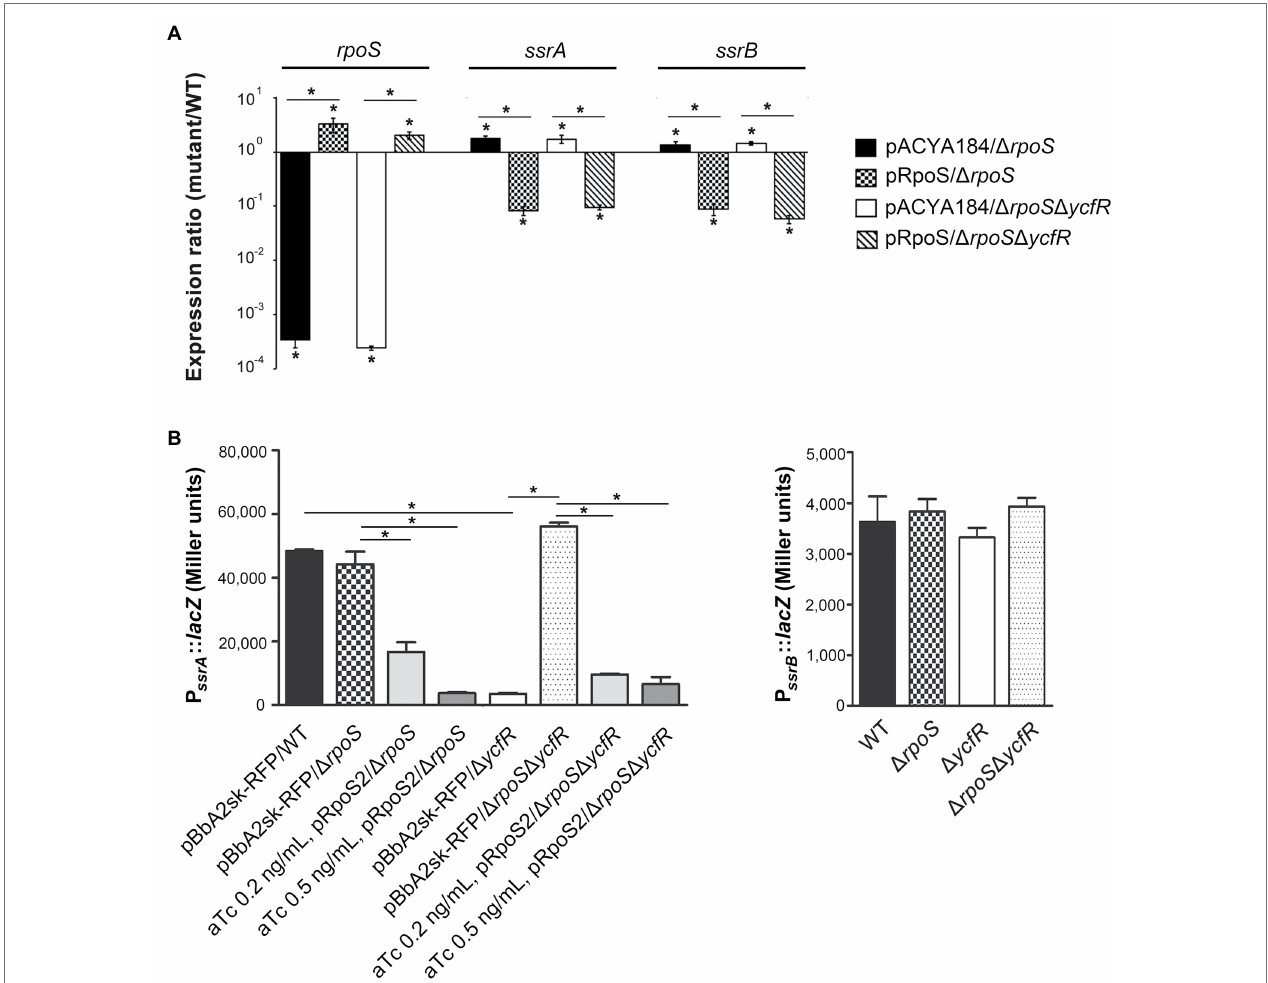
FIGURE 4 | Negative regulation of ssrA by RpoS. (A) Transcription levels of rpoS , ssrA , and ssrB were measured using qRT-PCR. Salmonella strains, including wild-type, Δ rpoS , and Δ rpoS Δ ycfR strains, were transformed with pRpoS or pACYC184 and cultivated to the stationary growth phase in LB medium broth. Ct values of rpoS , ssrA , and ssrB were normalized using those of gyrB gene. Expression levels of rpoS , ssrA , and ssrB from each strain were compared with those from wild-type strain harboring pACYC184 and the fold-change (mutant/wild-type) was plotted. Value of p with p < 0.05 is denoted with an asterisk. (B) Transcription from P ssrA and P ssrB was measured using lacZ transcriptional fusions. Plasmids pSsrA:: lacZ (left) and pSsrB:: lacZ (right) were introduced into wild-type, Δ rpoS , Δ ycfR , and Δ rpoS Δ ycfR strains. To overexpress RpoS, pRpoS2 and its empty plasmid pBbA2sk-RFP were introduced into wild-type and mutant strains, and aTc of 0.2 or 0.5 ng/ml was added in the LB medium broth cultures. β -galactosidase assay was conducted with bacterial cells at the stationary growth phase. An asterisk indicates a value of p <